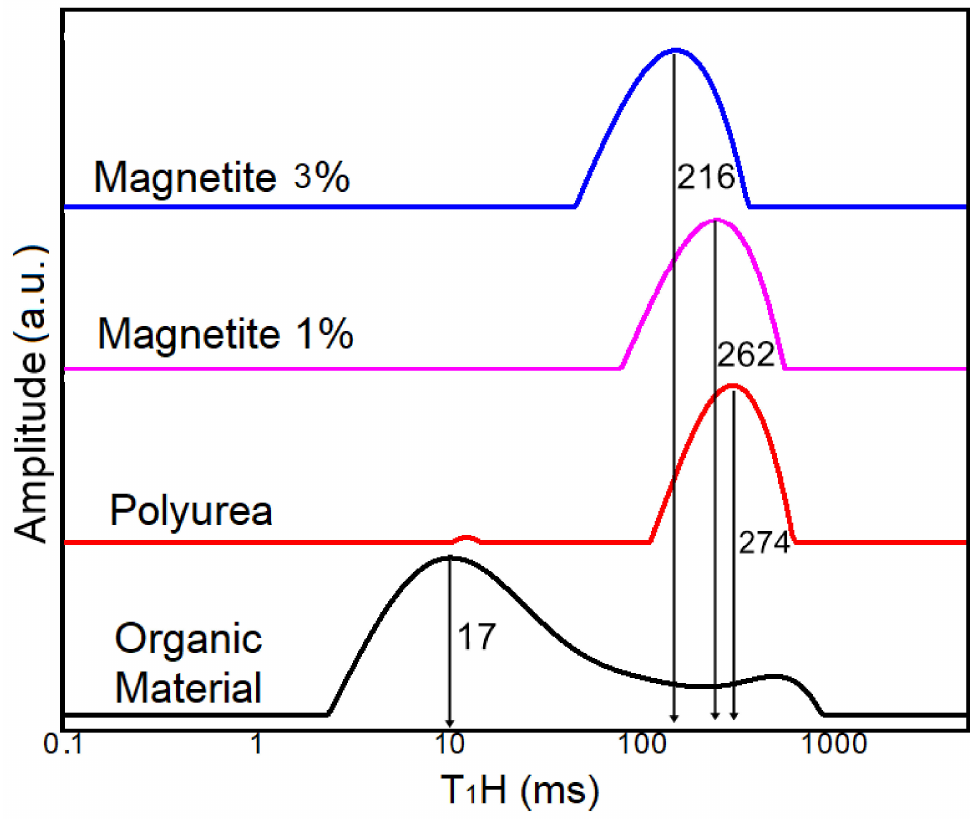
Figure 6. Relaxation time distribution curves (T 1 H) of polyurea and their 1% and 3% magnetite- modified